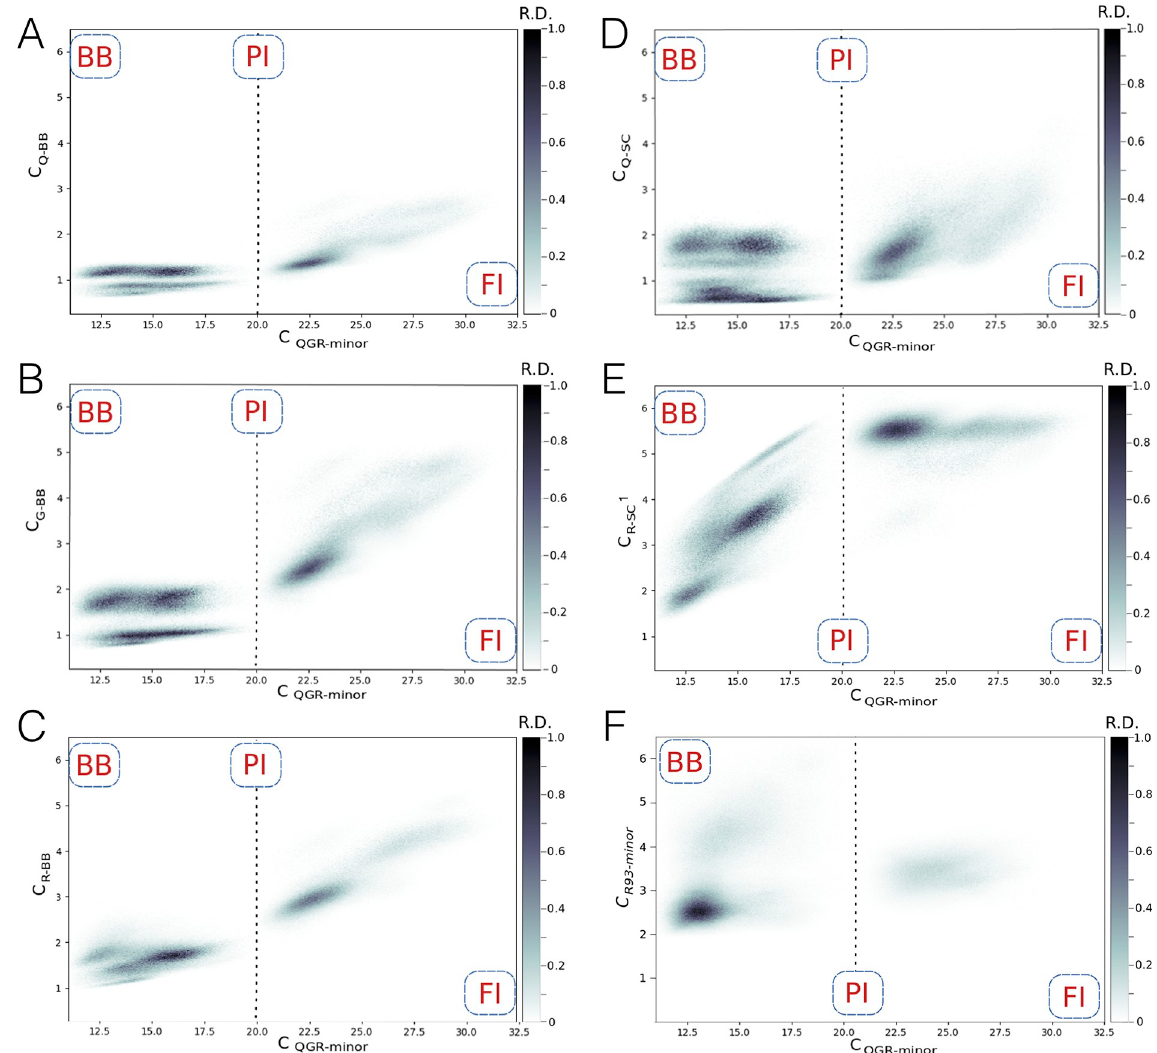
Fig 7. Probability density plots of the RETIS trajectories for the BB to PIto FI transition. The horizontal axis represents the number of contacts between hydrogen bond donors in the QGR motif and hydrogen bond acceptors at the minor groove side of the AT basepairs c QGR − minor . The vertical axis represents a local number of contacts between the minor groove side of the AT basepair and (A) the backbone N of Q112 c Q − BB , (B) the backbone N of G113 c G − BB , (C) the backbone N of R114 c R − BB , (D) the side chain NE2 of Q112 c Q − SC , (E) the side chain and (F) the hydrogen bond donors N, NZ, NH1 and NH2 in R93 c . The labels indicate the location of the states on NH1 of R114 c R − SC 1 R 93 − minor the horizontal axis. The dashed line indicates the location of the PI state. The color indicates the relative density. Darker regions are more often visited. White areas have not been